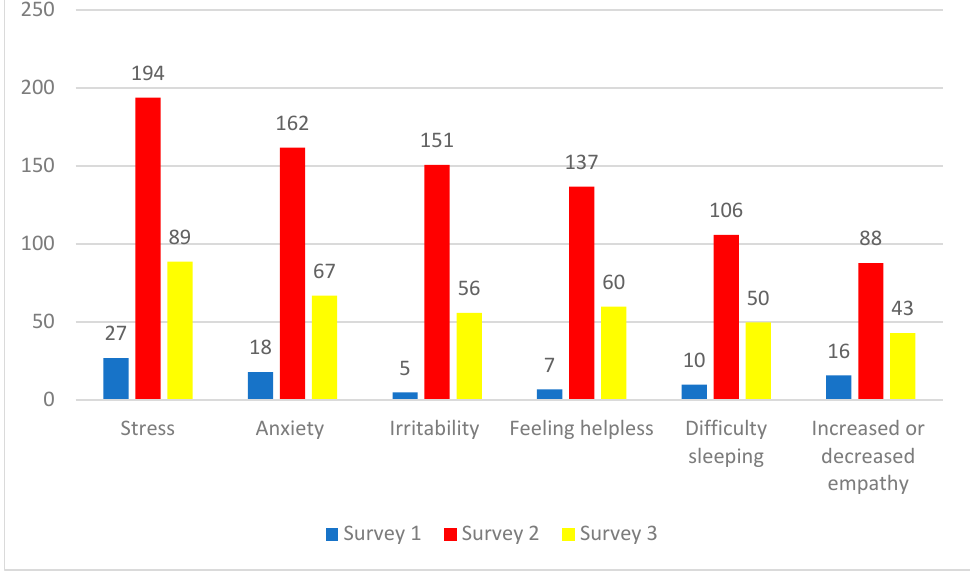
Table 2. Participants’ perspectives of the main ethical challenges faced, or to be faced, by